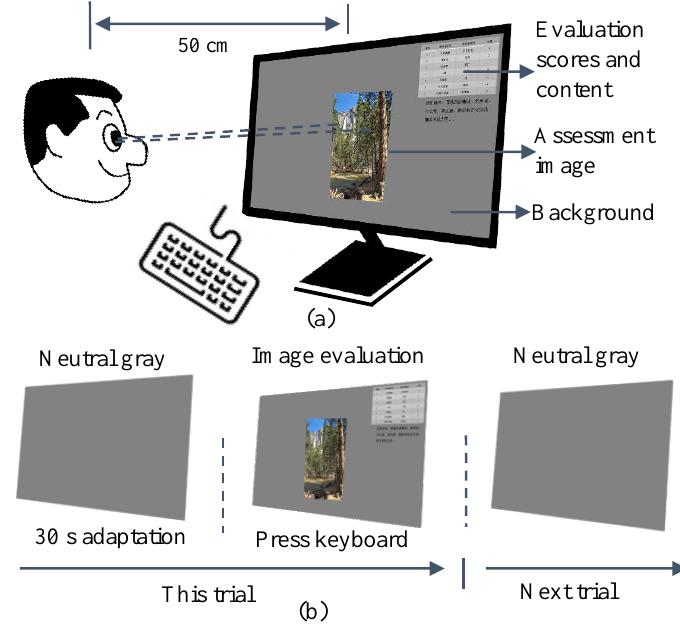
Figure 2. Diagram of the experimental procedure for subjective visual evaluation. ( a ) Tone mapped images, and the neutral grey background (20% grey). The evaluation content is on the upper right corner of the screen. The observation distance was 50 cm, and the field of view was 5°. ( b ) Each trail included 30 s adaptation [27], and then the images were evaluated by pressing the numbers on the keyboard.